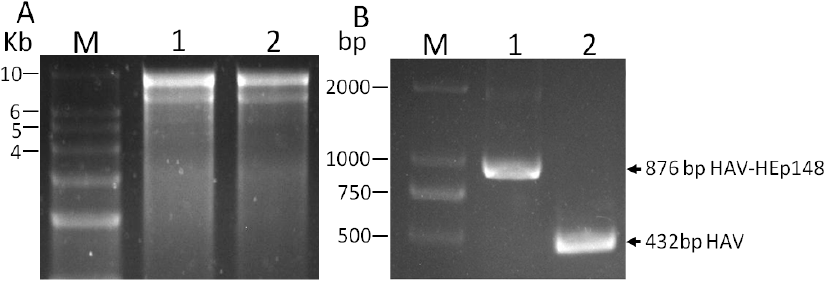
Figure 2. Rescue of the HAV constructs containing the HEp148 gene at the 2A/2B junction. ( A ) RNA transcribed from pT7-HAV-HEp148 with T7 RNA polymerase. Lane M indicates RNA size markers, lane 1 indicates plus-strand RNA of the HAV-HEp148 virus, and lane 2 indicates plus-strand RNA from the wild-type HAV virus. The sizes of the marker bands are in kb; ( B ) RT-PCR results show the HEp148 insertion. Viral RNA was extracted and fragments were amplified with RT-PCR using HAV primers specific for HAV nucleotides (nts) 3137 to 3161 and 3544 to 3568, spanning the HEp148 insertion. RT-PCR fragments amplified from RNA extracted from HAV-HEp148 (lane 1) and wild type HAV (lane 2) were analyzed with 1.5% agarose gel electrophoresis. The RT-PCR fragments from HAV-HEp148 and parental HAV are indicated by arrowheads, and their sizes given in base pairs (bp). The size of the DNA molecular weight markers (lane M) is indicated in thousand base pairs (kb).